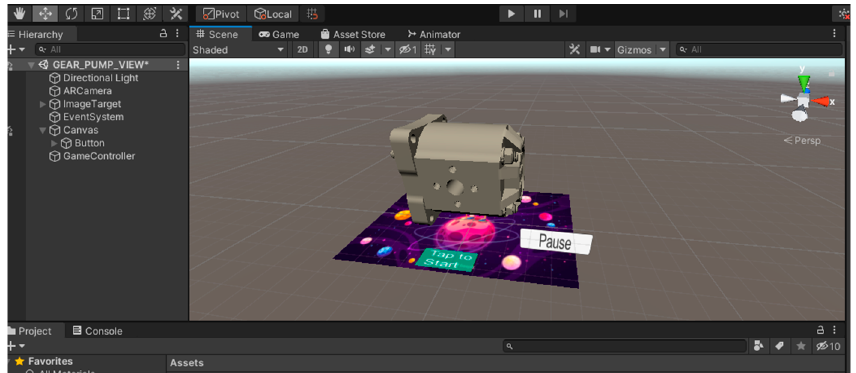
Figure 15. View of the workspace in Unity.